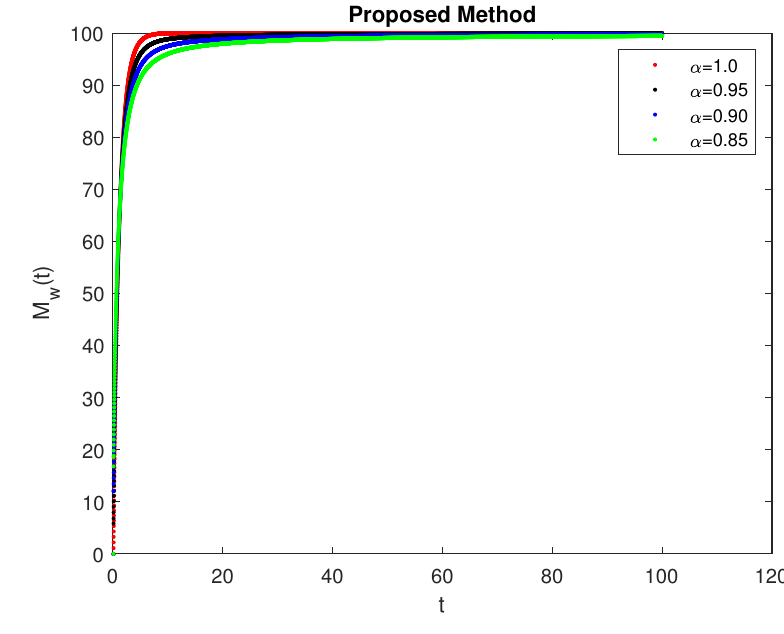
Figure 9: Numerical simulations for τ = 0.9 for ABC derivative.